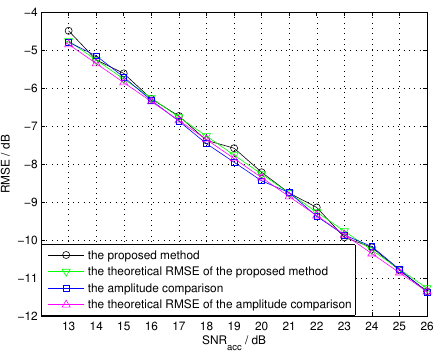
Figure 11. The performances of the amplitude comparison angle estimation (ACAE) and CCAE for the target containing 17 scatterers in different SNR